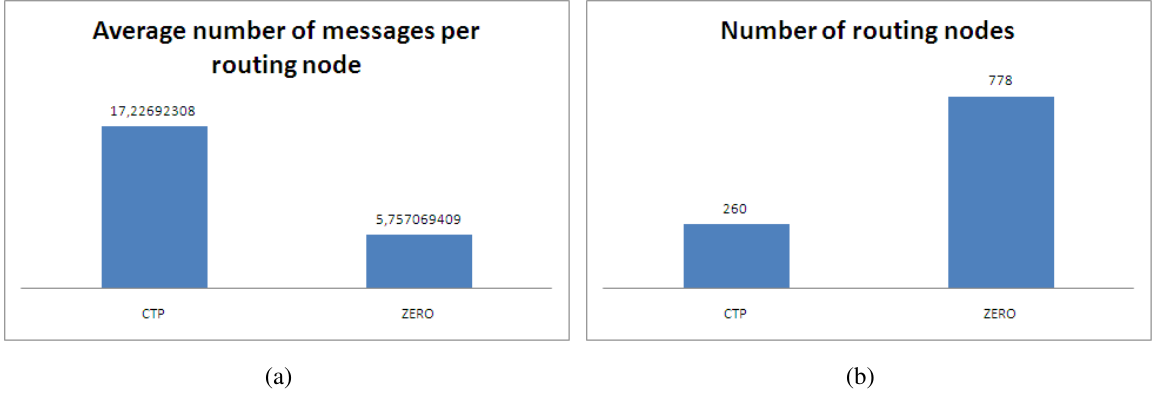
Figure 3. Number of messages per routing node and number of nodes routing information from other nodes. (a) Average number of messages per routing node (in average for the 50 repetitions of the experiment), (b) Number of nodes routing messages from other